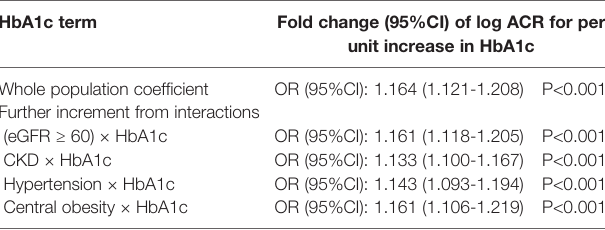
TABLE 3 | Interactions between CKD, hypertension, HbA1c and ACR. HbA1c